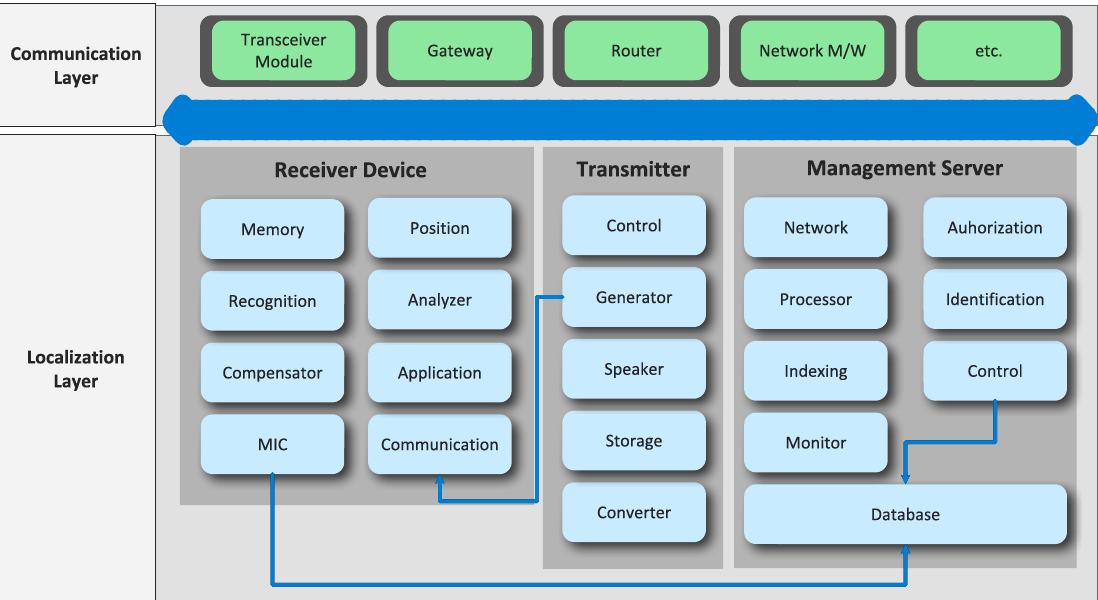
Figure 5. The physical architecture of the ILMS